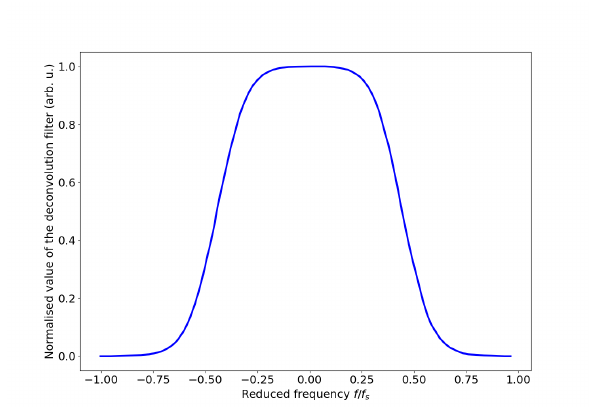
Figure 3. Target deconvolution filter D (1D slice) obtained with the Wiener-Tikhonov method as a function of the reduced spatial frequency (frequency f over the Nyquist frequency f s